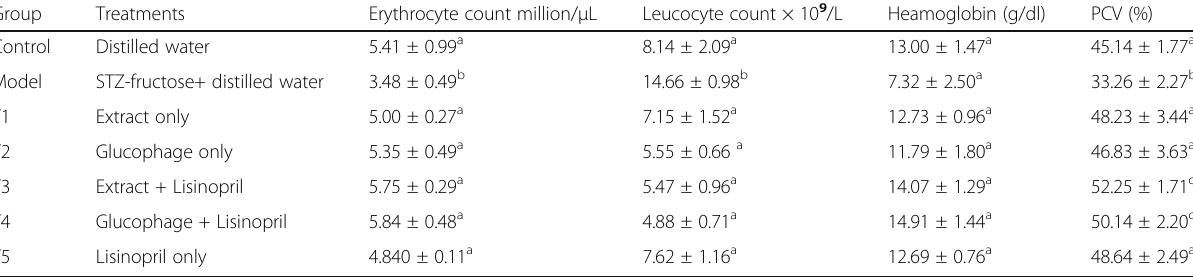
Table 5 Effect of combined administration of lisinopril and ethanolic bark extract of E. chlorantha on Erythrocyte count, Leucocyte count, Heamoglobin and PCV level in type 2 diabetic rats